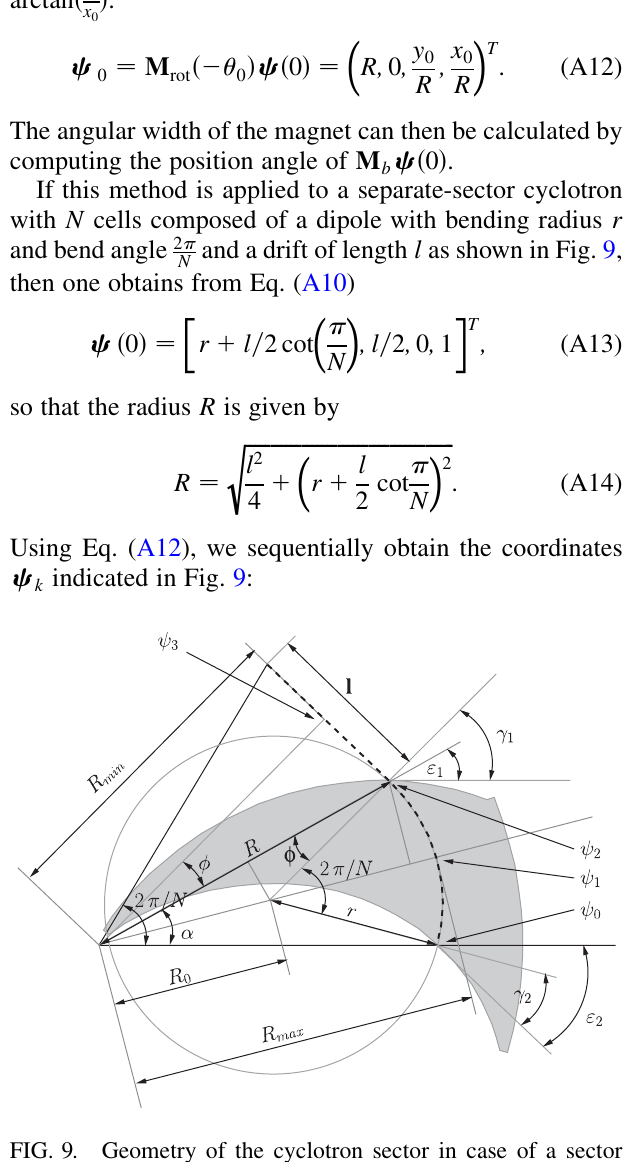
magnet (gray area) with a constant field along the closed orbit (shown as a thick dashed line). " 1 and " 2 are the spiral angles of the entrance and exit of the magnet. (cid:3) 1 and (cid:3) 2 are the angles between the sector entrance and exit and the orbit normal